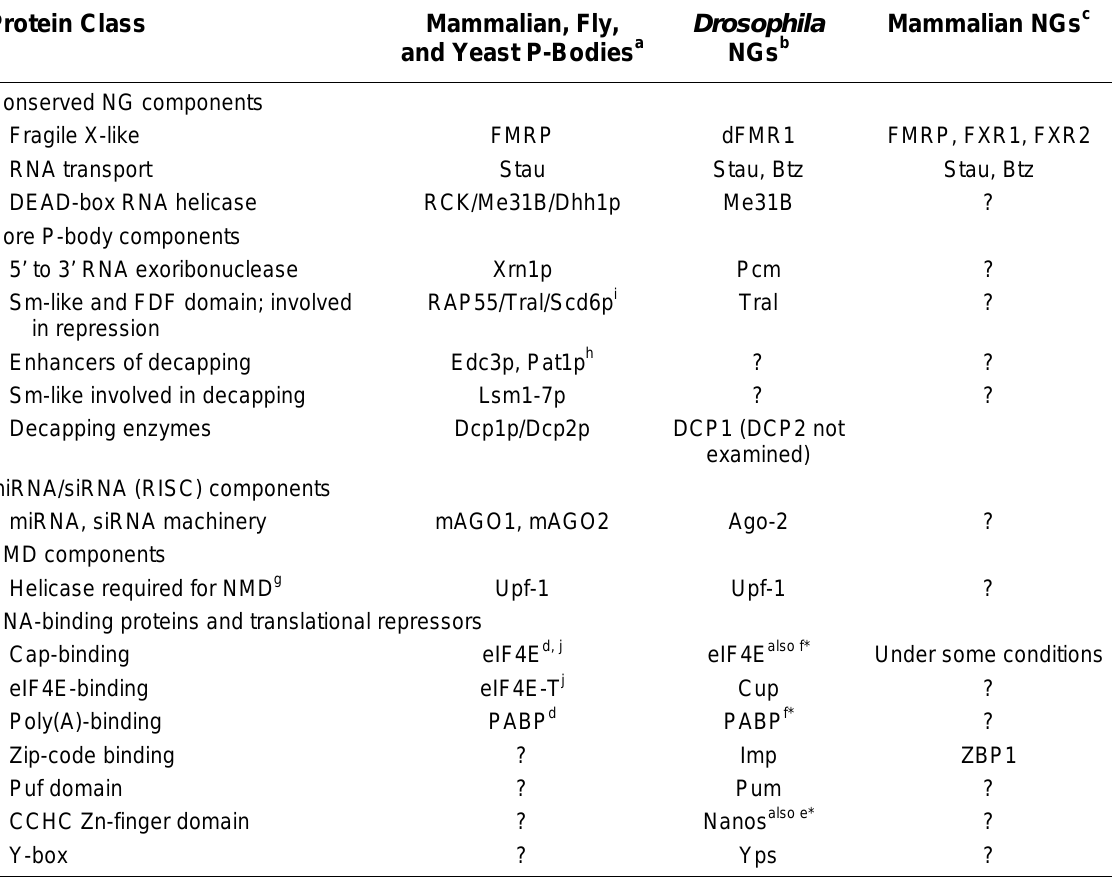
Conserved Components of P-Bodies and